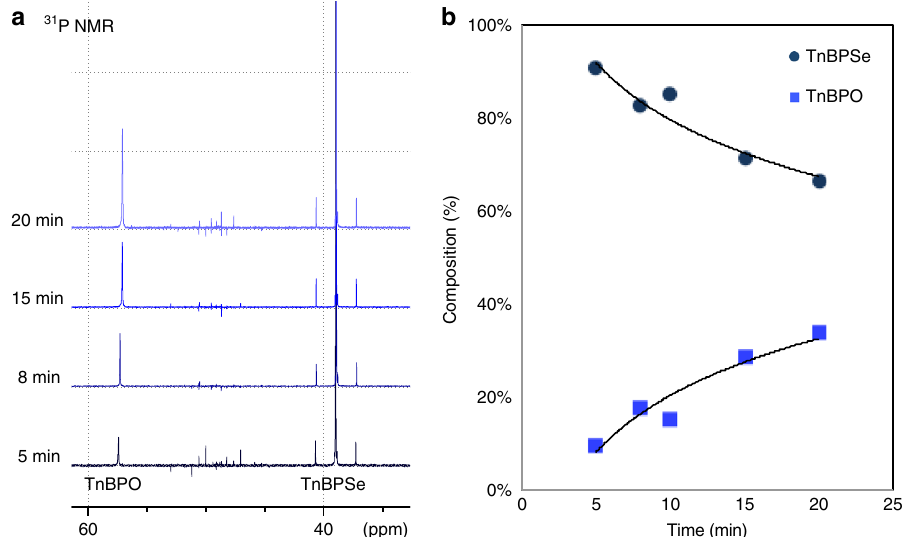
Fig. 1 A NMR analysis following decomposition of TnBPSe after hot injection. a The 31 P NMR spectrum of the reaction mixture over time, showing that the relative amount of TnBPSe decreases as the amount of TnBPO increases. b The percent composition of TnBPSe (navy blue circles) and TnBPO (royal blue squares) in the TnBPSe decomposition reaction over time. 31 P and 77 Se NMR of TnBPSe before reaction can be found in Supplementary Fig. 1. Trend lines are provided as guides to the